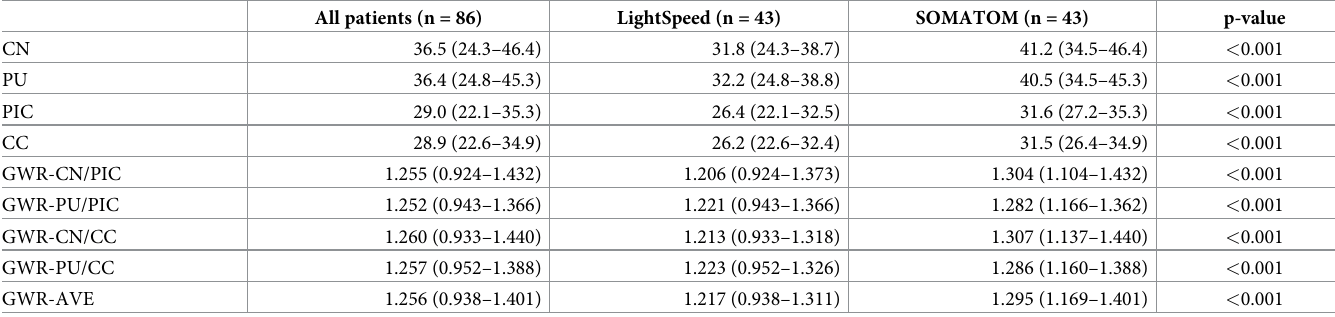
(Table 2). The analysis of neurological outcomes clearly showed a difference between scanners. In the good outcome analysis, the GWR-AVE of the Lightspeed scanner was 1.266 (IQR, 1.240– 1.275), and that of the SOMATOM scanner was 1.328 (IQR, 1.312–1.349). In the poor out- come analysis, the Lightspeed scanner was 1.220 (IQR, 1.177–1.242), and the SOMATOM 100% specificity in the ROC curve analysis that predicts the poor neurological outcome of Table 2. The density of measured HUs value and GWR according to CT scanner. All patients (n =